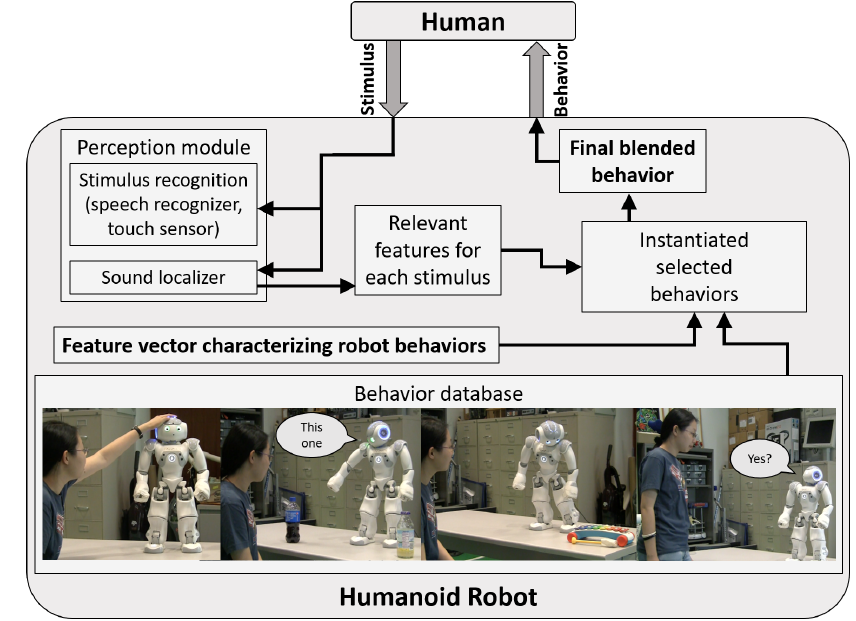
Figure 3: Architecture of our customizable autonomous agent; stimuli are recognized and trigger different behaviors, according to the cus- tomizable feature vector characterizing the